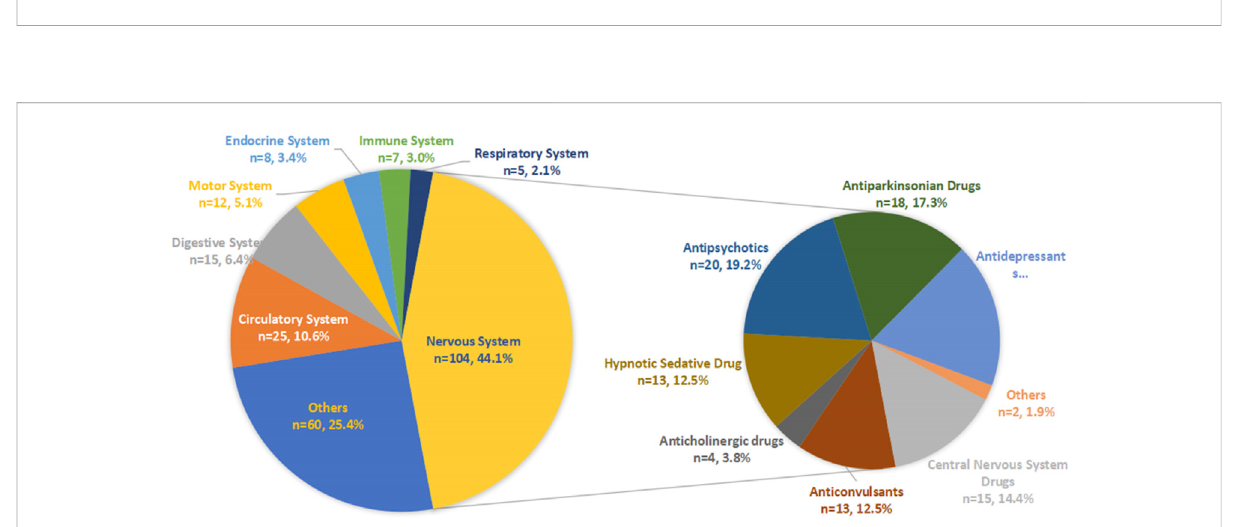
FIGURE 2 CharacteristicsofpatientsandADEsreportsincludedintheanalysis (A) theageandsexdistributionofincludedpatients, (B) thenumberofADEs reported per year, (C) the outcomes of included patients.